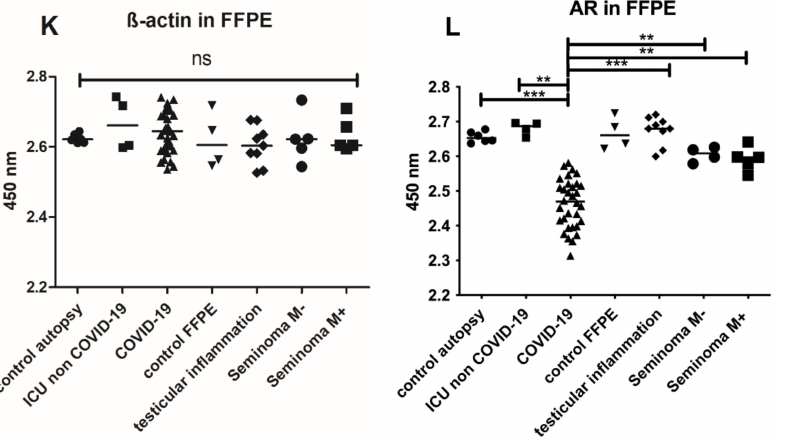
Figure 2. Upper part: IHC from testicular tissue samples. ( A , B ) present a slightly reduced spermato- genesis and normal AR expression in healthy control tissue sample (brownish marked nuclei, clone AR441) ( C , D ) Example of COVID-19 positive patient with no expression of the AR as well as a re- duced spermatogenesis. ( E , F ) are examples of inflammatory changes control and ( G , H ) from autopsy of a case of previous intensive care treatment. ( I , J ) autopsy of vaccinated man dying of COVID-19. Figures exemplified a collective of each analyzed group used. Left side H&E (spermiogenesis yellow arrowheads), right side IHC for androgen receptor AR441 (black arrowheads), each at 400 × magnifi- cation. Lower part: Androgen receptor ELISA from FFPE tissue. Total protein was isolated from FFPE tissue and 1 µ g of total protein was used for the analysis by ELISA. Significant decreased AR values were found in testicular tissue samples compared with control group. *** p < 0.0001, ** p < 0.001, unmarked = ns. Control ELISA for ß-actin to control isolation quantity ( K ). Detection of AR protein in FFPE samples ( L ). Significant reduction in the AR levels in COVID-19 samples ( ± 30%) compared to control autopsy and ICU non COVID-19 were detectable (*** p <